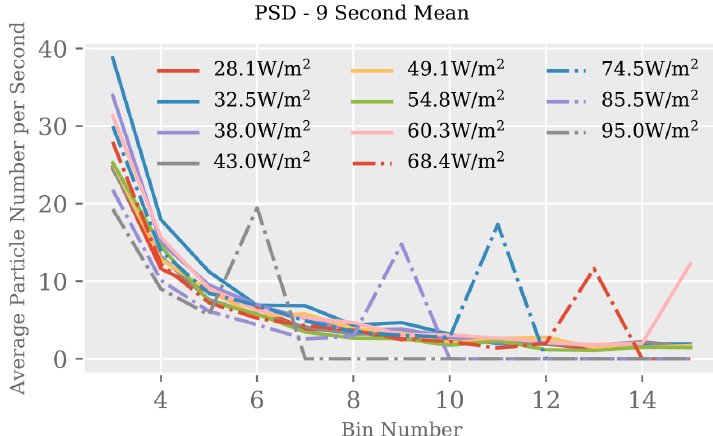
Figure B1. The results from the RCASS stray-light test. Each line on this graph represents a different irradiance from the halogen bulb used as an analogue to the sun. Irradiances larger than this were found to completely saturate the photodiode and cause no counts to be